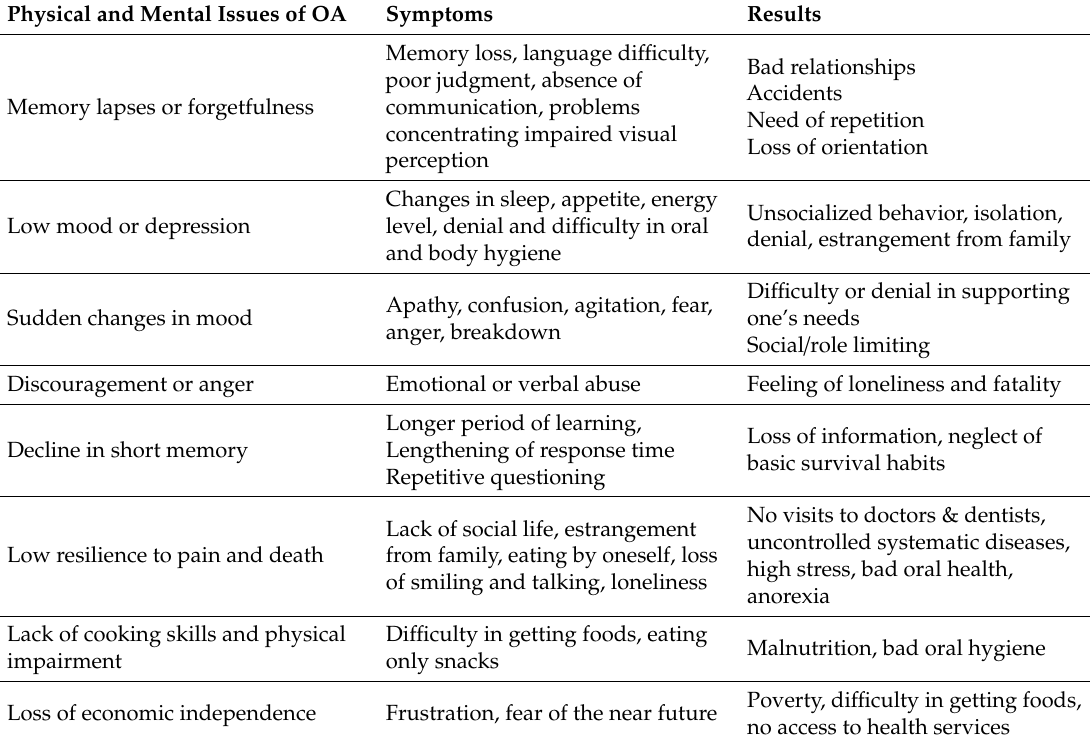
Table 1. Physical and mental issues of Older adults (OA) that resist change of